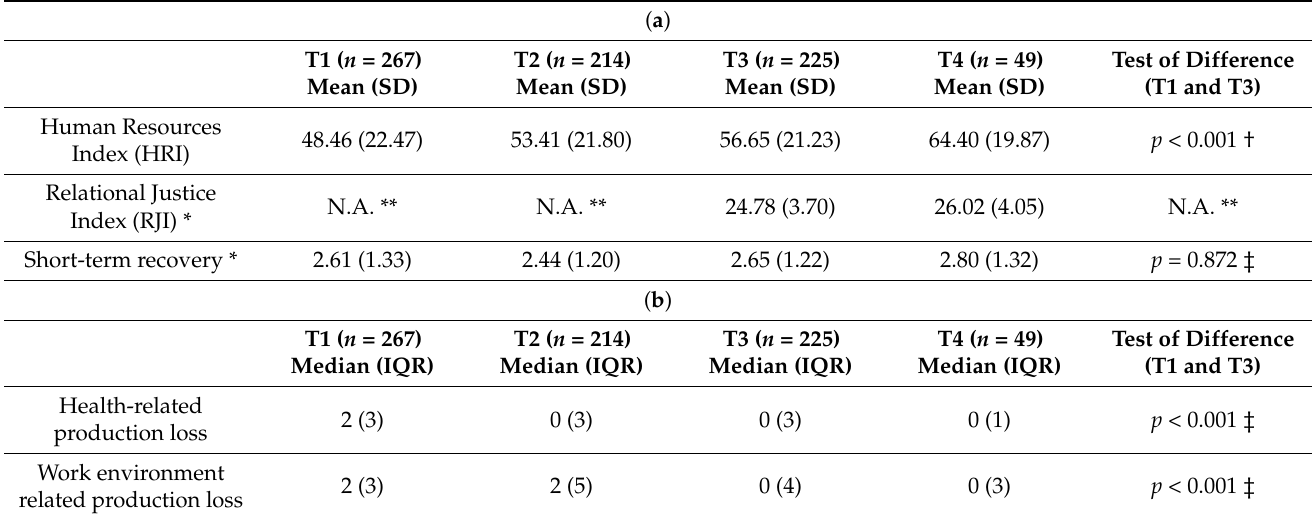
Table 1. ( a ) Descriptive statistics for t1 to t4. ( b ) Descriptive statistics for t1 to t4.